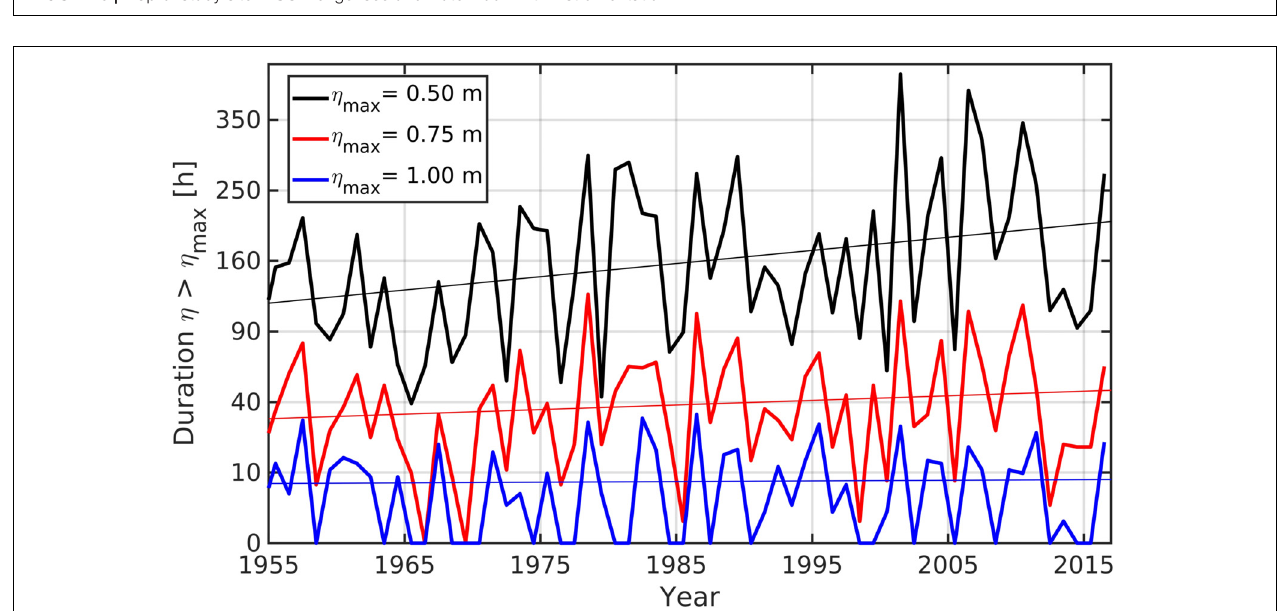
FIGURE 4 | Number of hours per year exceeding a certain mean sea level. The trend for the 0.5 m threshold above m.s.l. is significant (Southern Baltic Sea Coast). The time series of sea surface elevations were taken from the gauge at Warnemünde and were provide by the Federal Maritime and Hydrographic Agency of